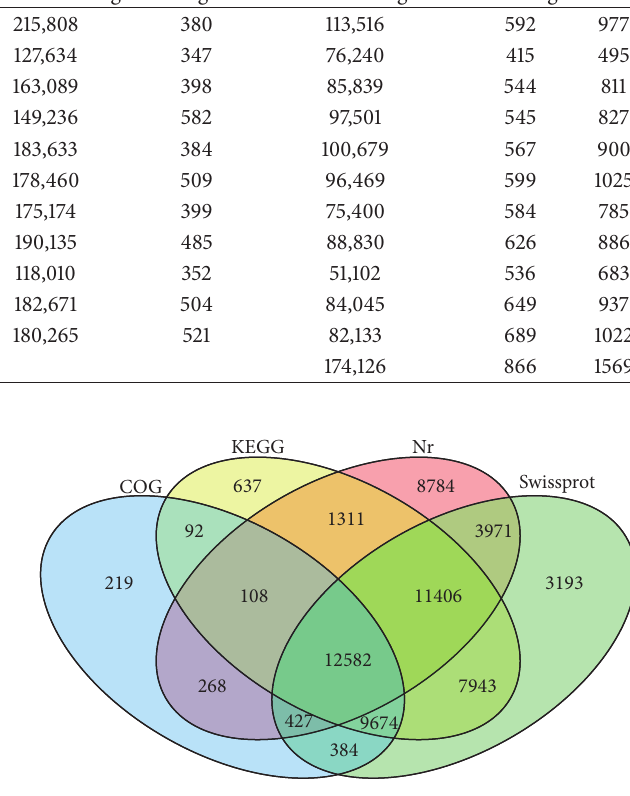
Table 2: Summary statistics of sequence assembly from 11 samples of the pearl oyster, Pinctada fucata . Sample